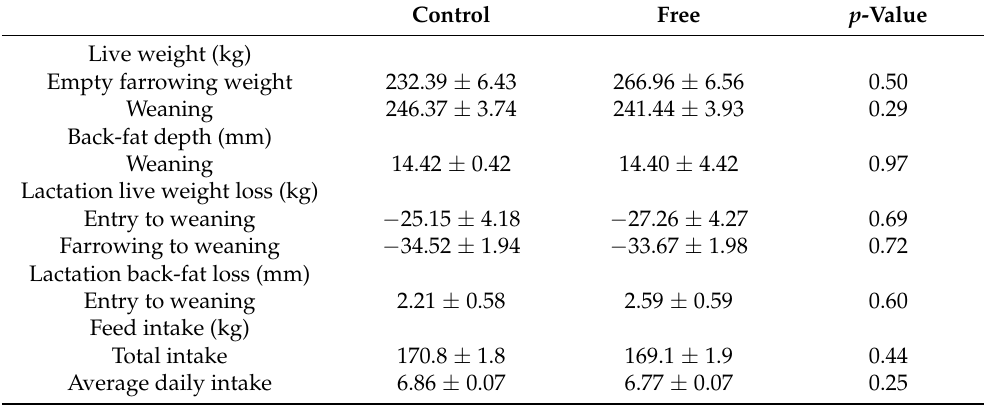
Table 1. Effect of management in a standard farrowing crate or a free lactation crate on live weight, back-fat depth and body condition loss during lactation.